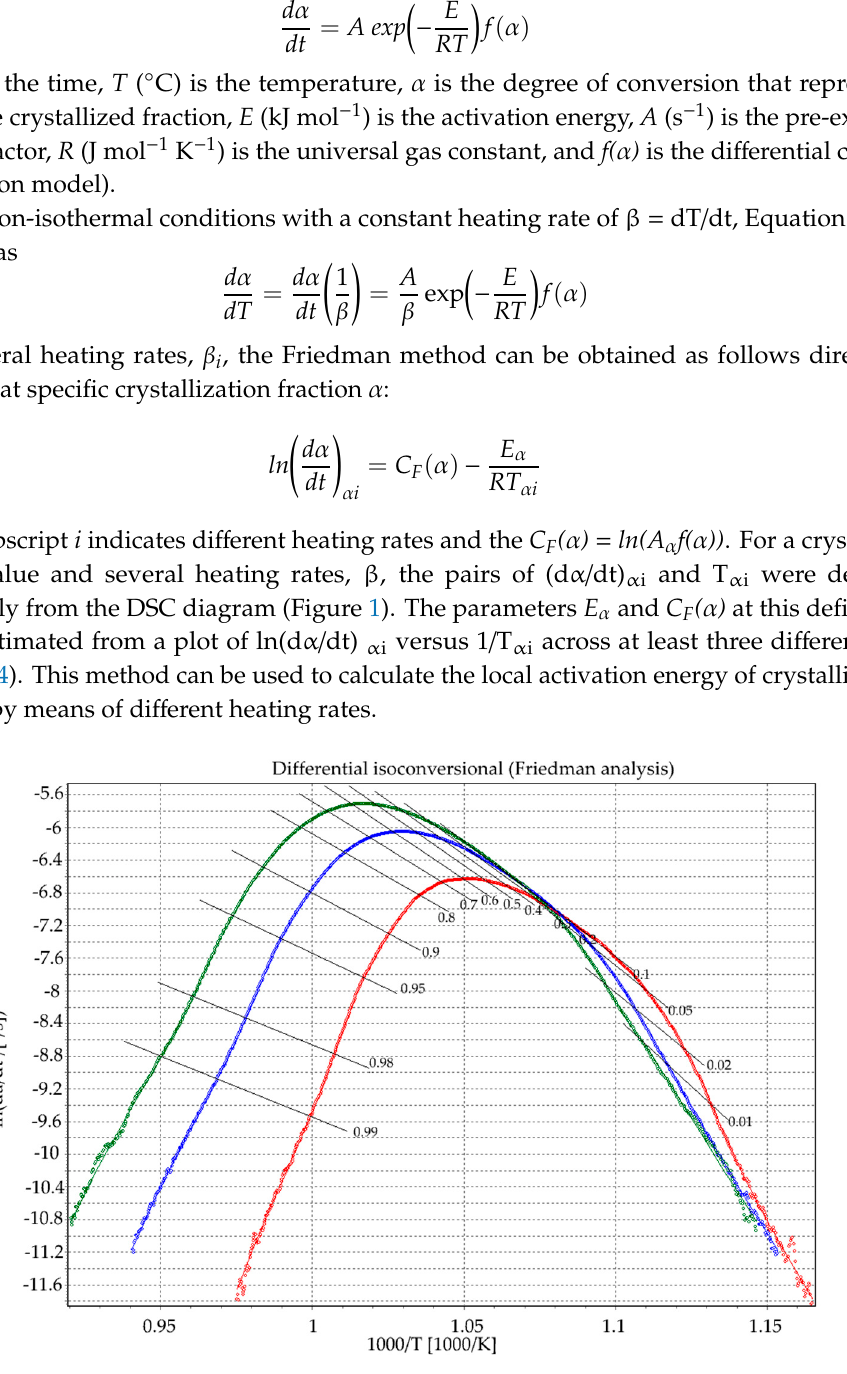
Figure 4. Isoconversional plots of ln(d α / dt) versus 1000 / T according to the Friedman method (with β i = 5, 10, and 15 K/min).